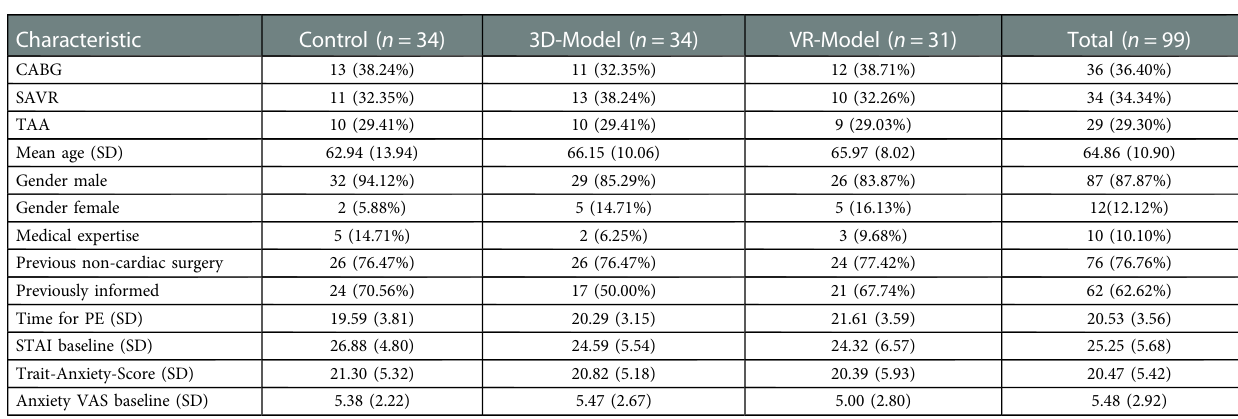
TABLE 1 Baseline